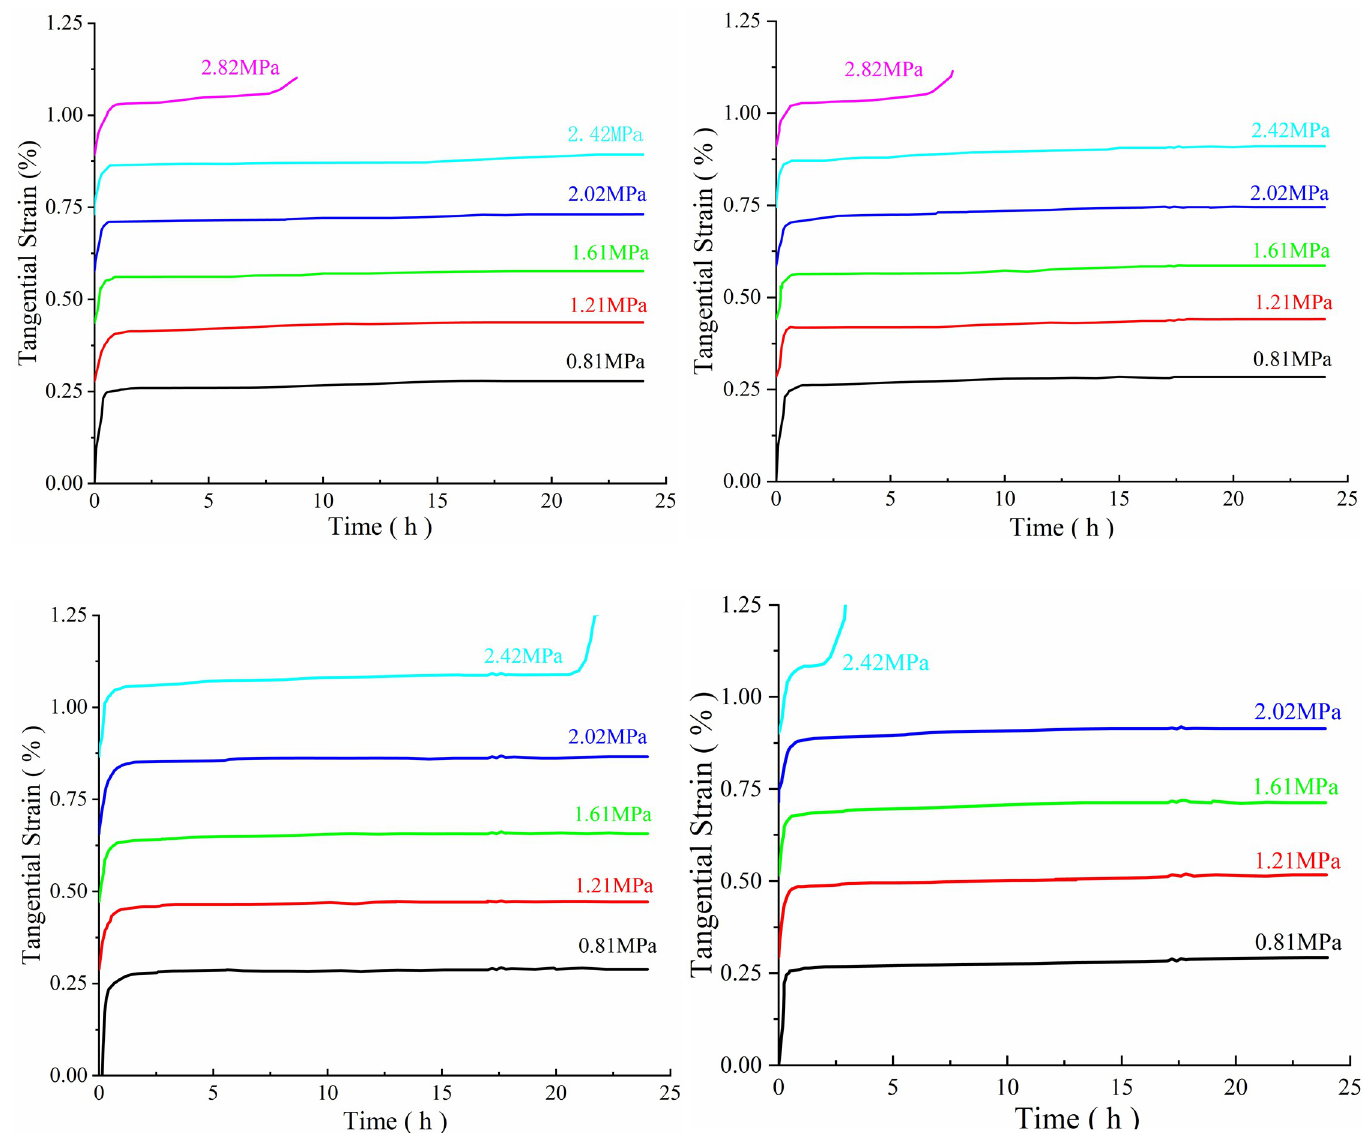
Fig 6. Shear strain curve over time for mud shale under different shear stress levels (a) Sample A 1 (axial pressure 1 MPa, impact energy 0 J); (b) Sample A 2 (axial pressure 1 MPa, impact energy 1.34 J); (c) Sample A 3 (axial pressure 1 MPa, impact energy 2.36 J); (d) Sample A 4 (axial pressure 1 MPa, impact energy 3.67 J).